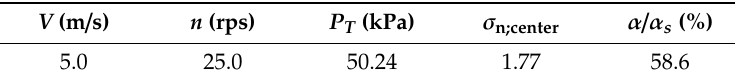
Table 3. Test conditions for noise measurement.